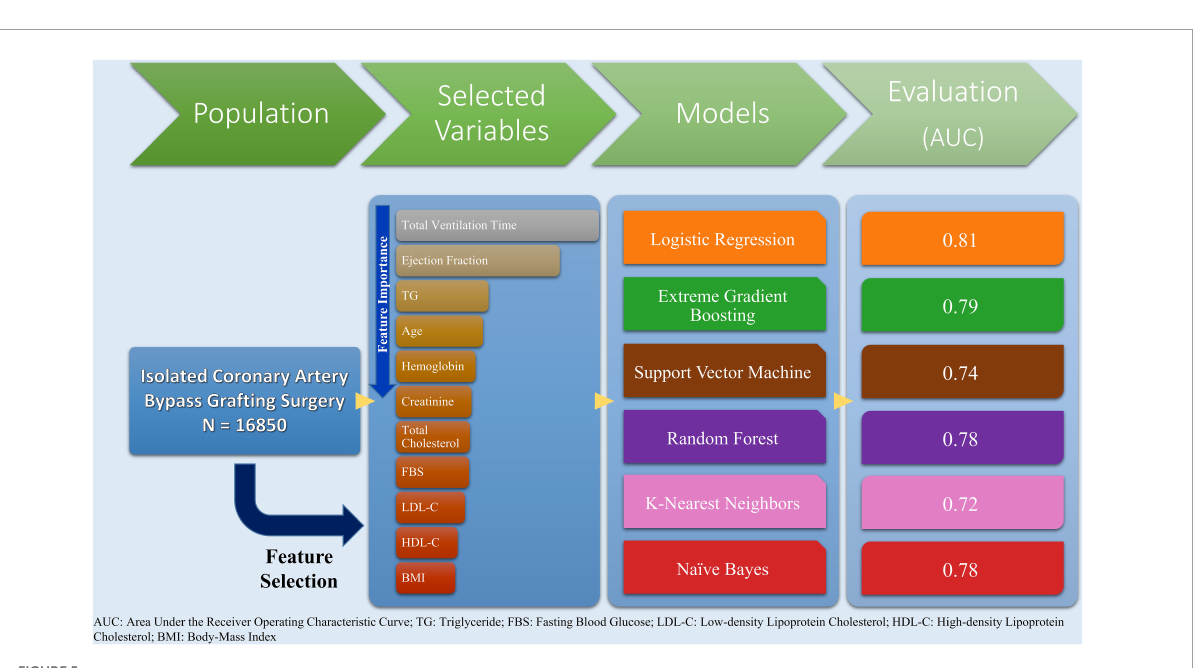
FIGURE5 Summary of study design and machine learning models development and